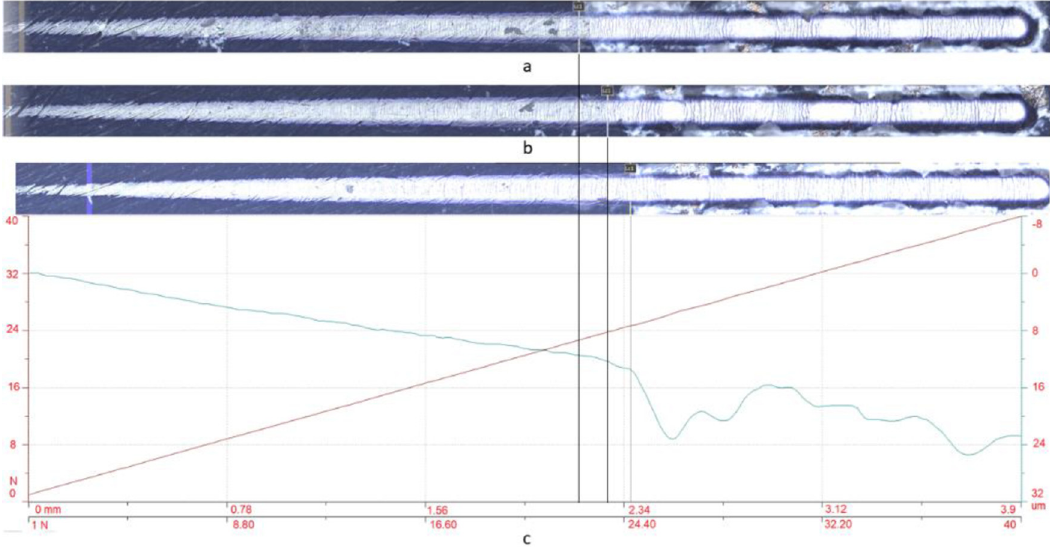
Fig. 3. Scratch test on the substrate manufactured by 3D printed process from Ni based superalloy and coated by EB-PVD with a multilayer fi lm of